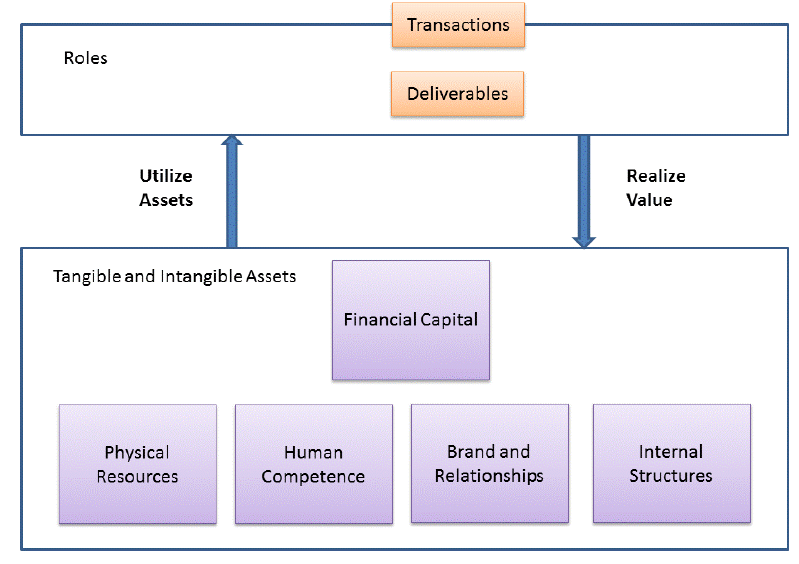
Figure 3 . Value Conversion Strategy Model